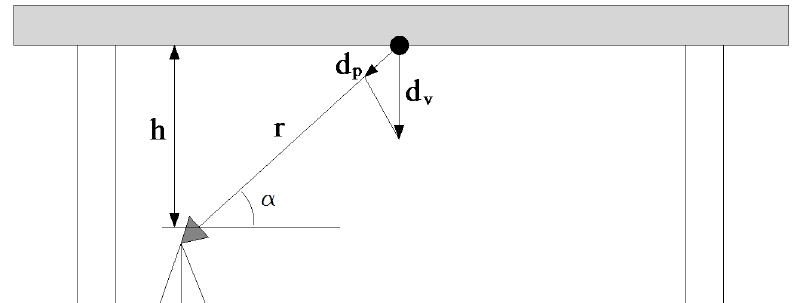
Figure 3. Radial displacements and their transformation.